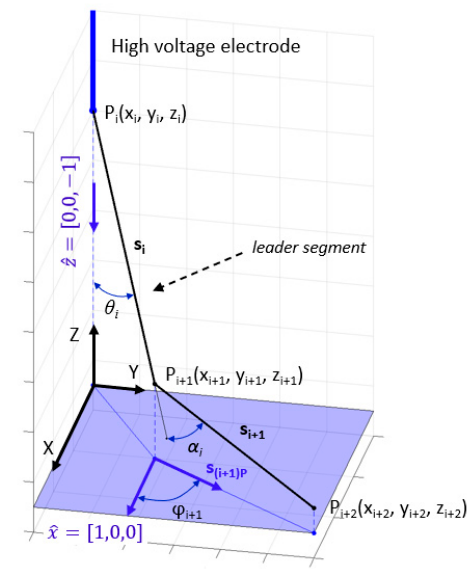
Figure 1. Tortuosity angles of discharge channel: α i , θ i , and φ i .